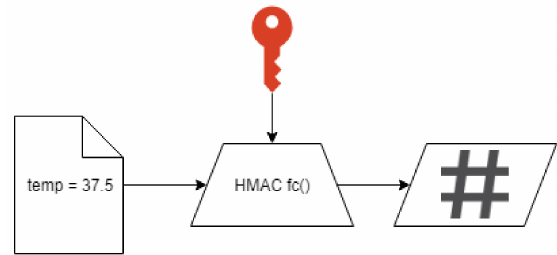
Figure 1. Hash-based Message Authentication Code